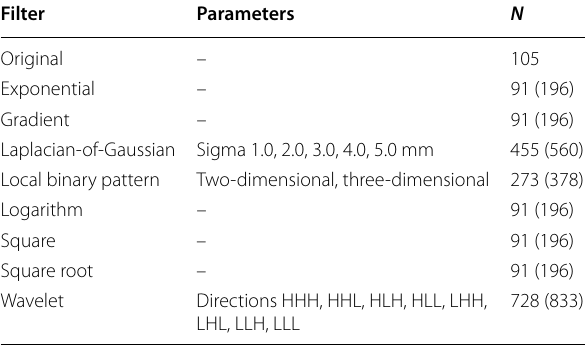
Table 2 Overview of the image filters